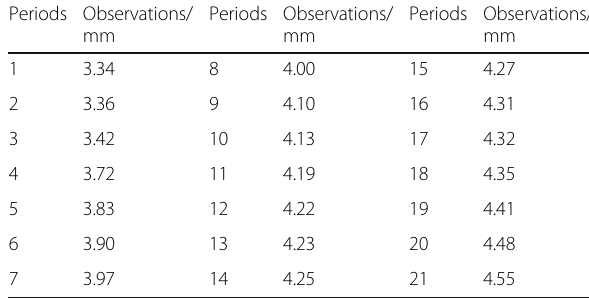
Table 1 Foundation pit monitoring